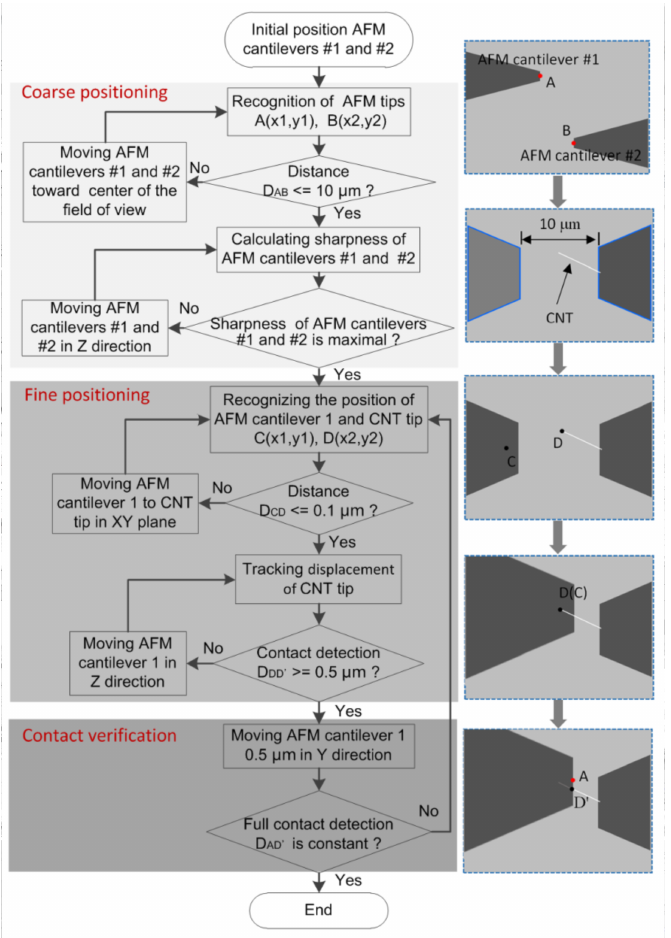
Figure 2. Flow chart for automated measurement on electrical conductivity of an individual